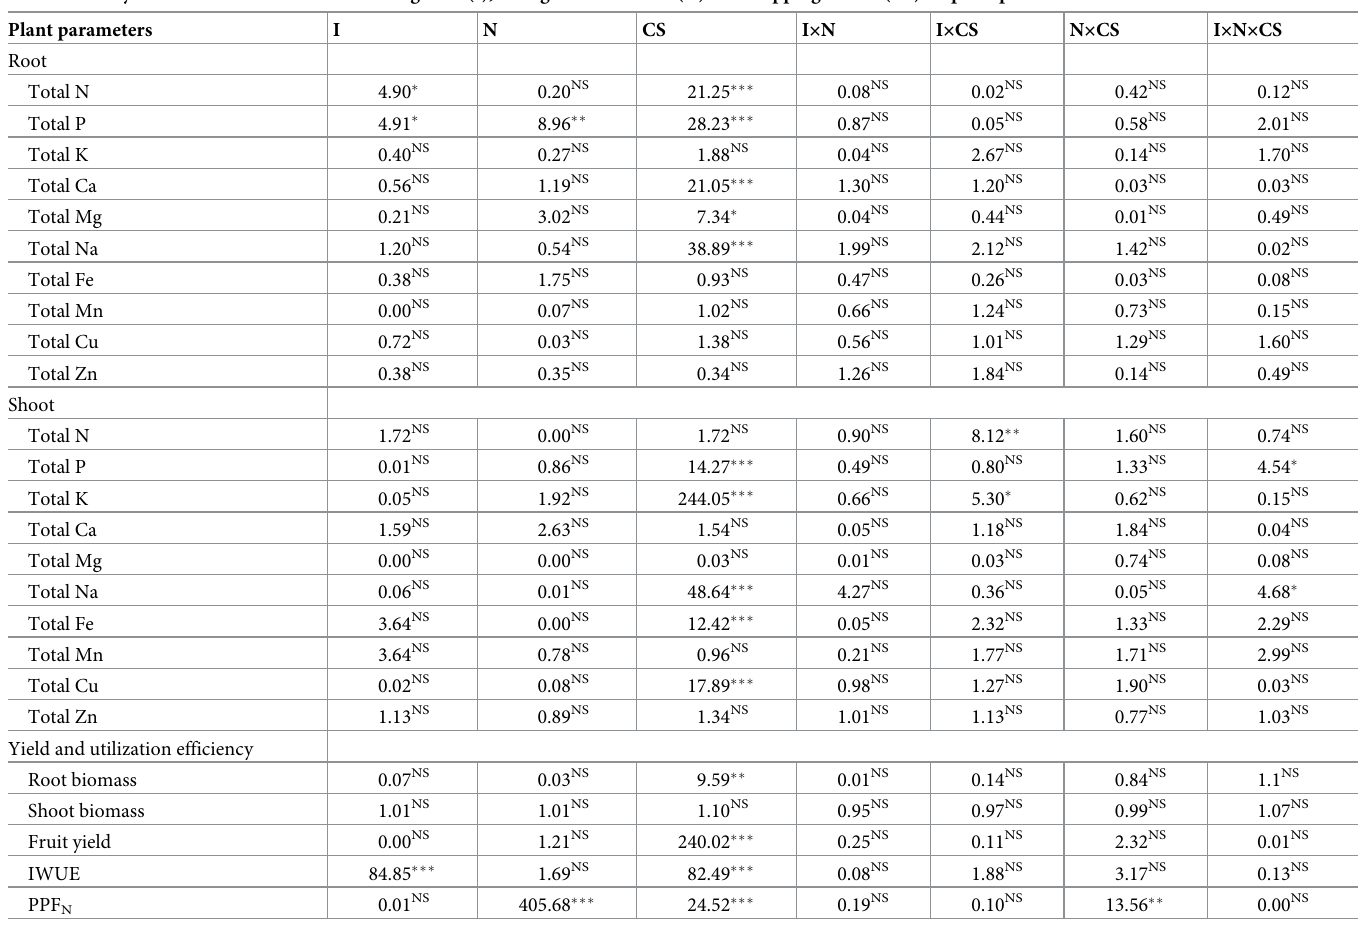
Table 5. Analysis of variance of the effects of irrigation (I), nitrogen fertilization (N) and cropping season (CS) on plant parameters. Plant parameters